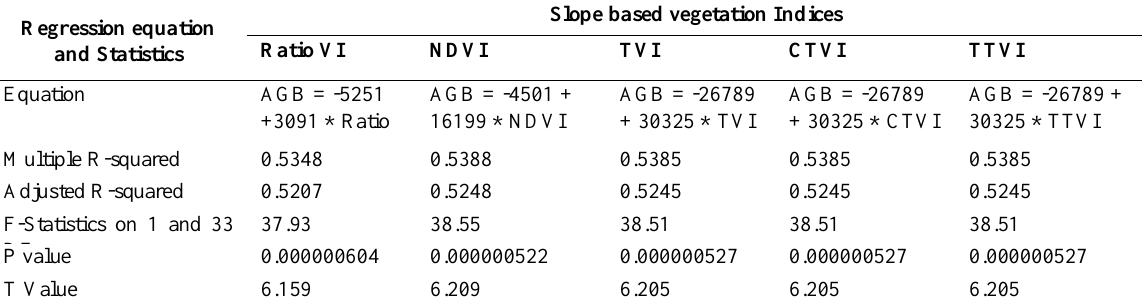
Table 2. Statistical summary of regression analysis between slope based VIs and AGB